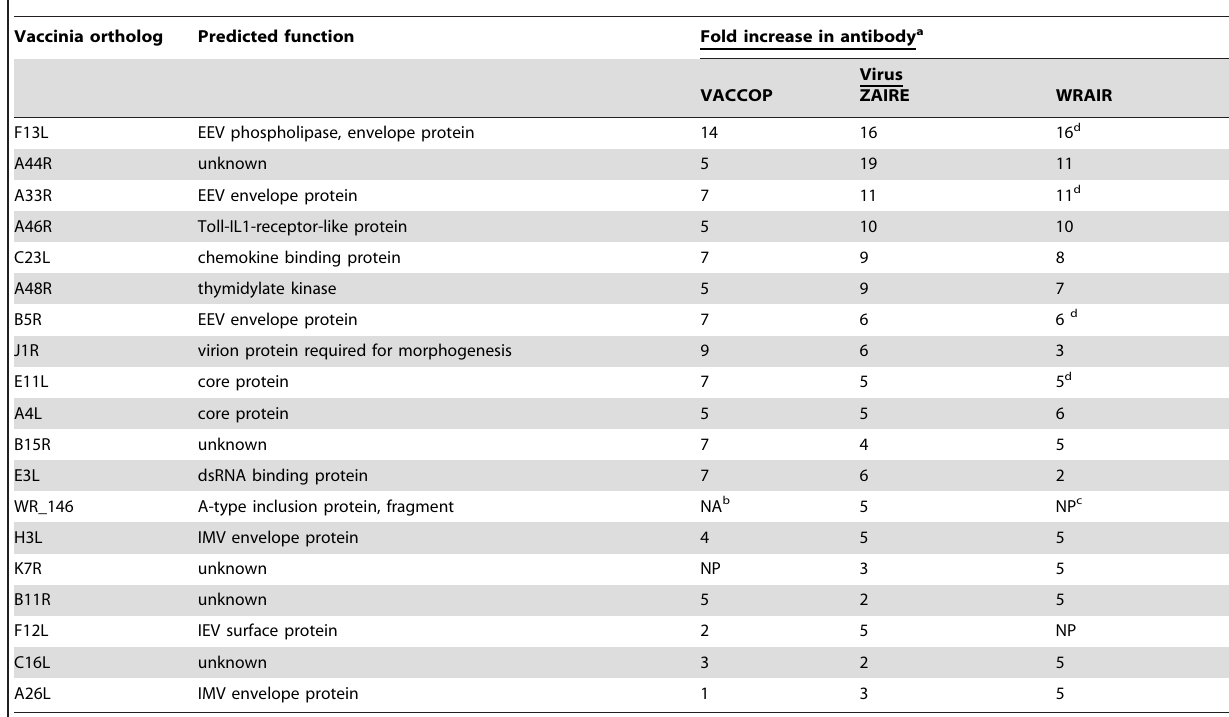
Table 2. Orthopoxvirus proteome recognized by IgM during acute infection.